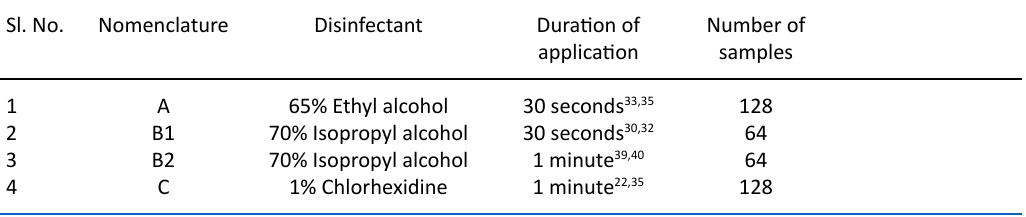
Table 1. Nomenclature of disinfectant used in the study and duration of application Sl.